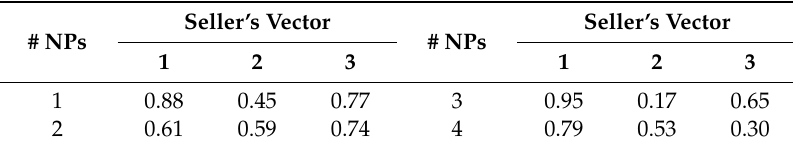
Table 7. NPs vector of 1 × S.